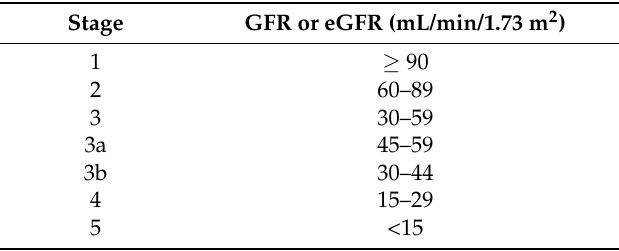
Table 1. Stages of chronic kidney disease as defined by glomerular filtration rate (GFR) or estimated glomerular filtration rate